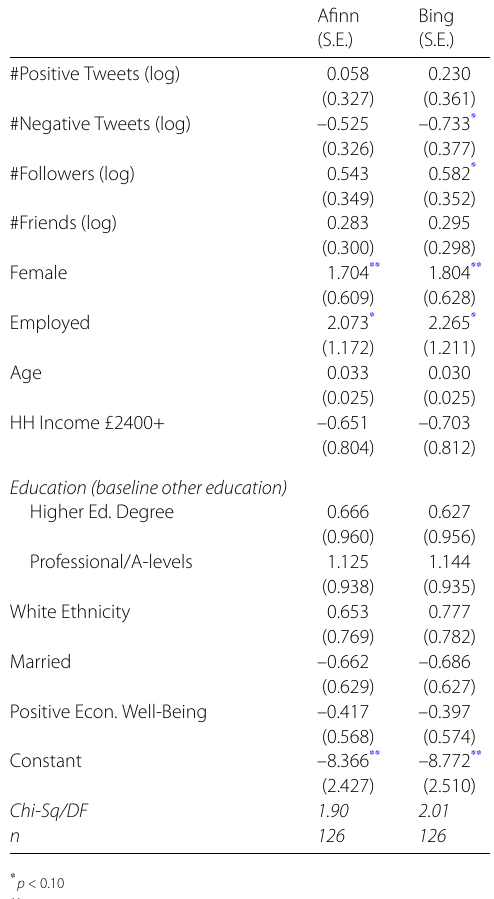
Table 5 Prediction of Unhappy Response from Sentiment Scored Tweet